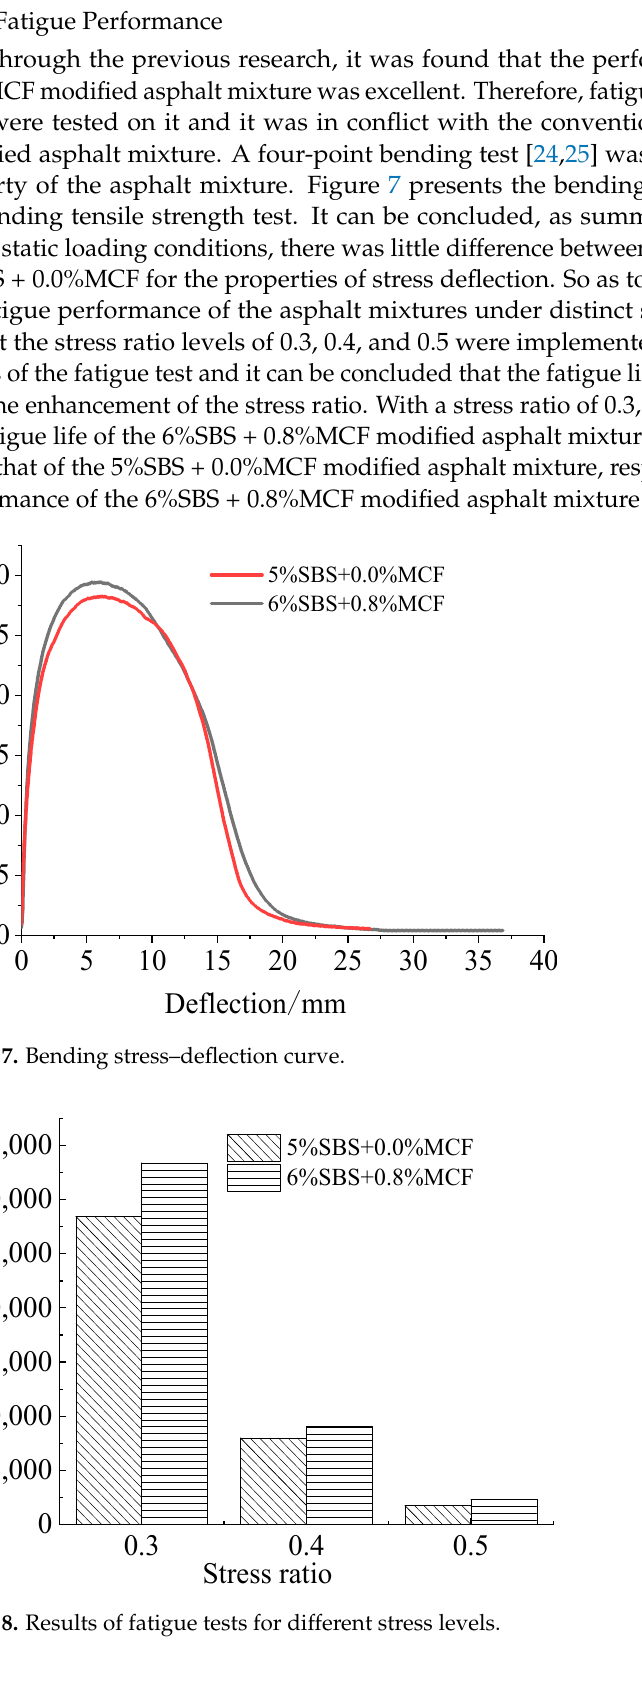
Table 10. Results of the dynamic modulus test for modified asphalt mixtures . Frequency/Hz